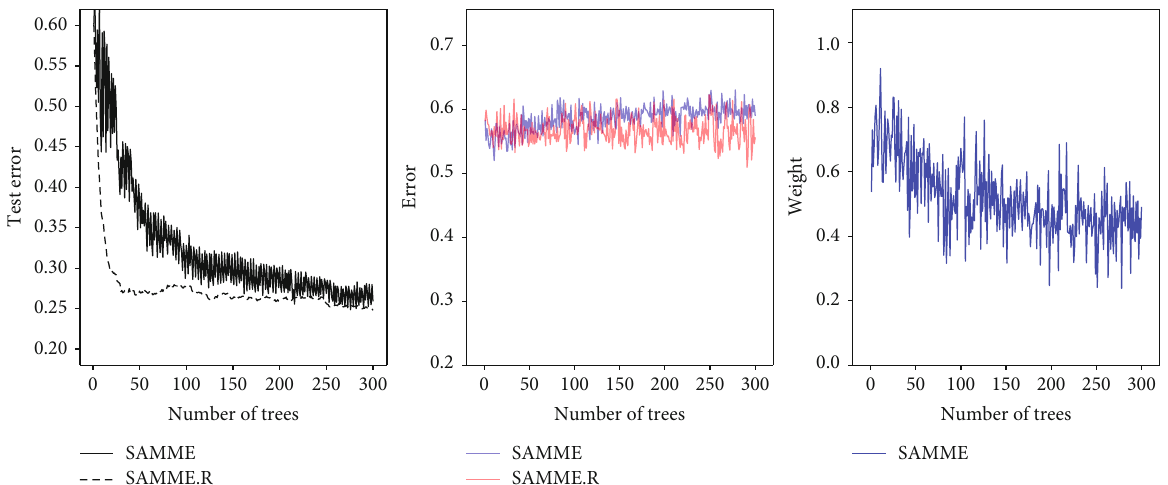
Figure 3: Graphical processing e ff ect of di ff erent algorithms.